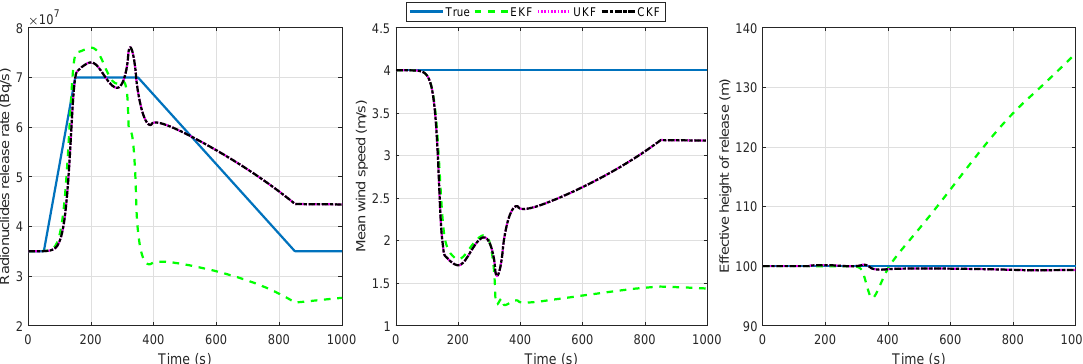
Figure 13. True and estimated release rate, wind speed, and height of release for multiple release